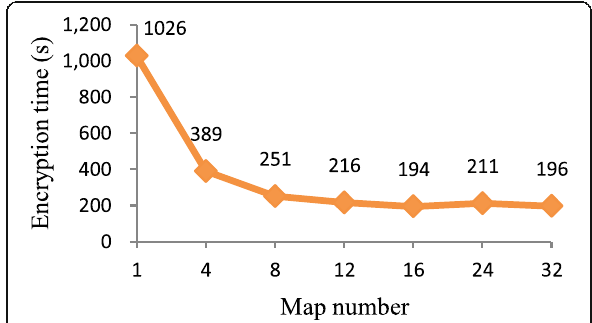
Fig. 5 The encryption time of 4 GB on different cores. The figure shows the encryption time of a 4-GB file allocates to different cores in parallel environments